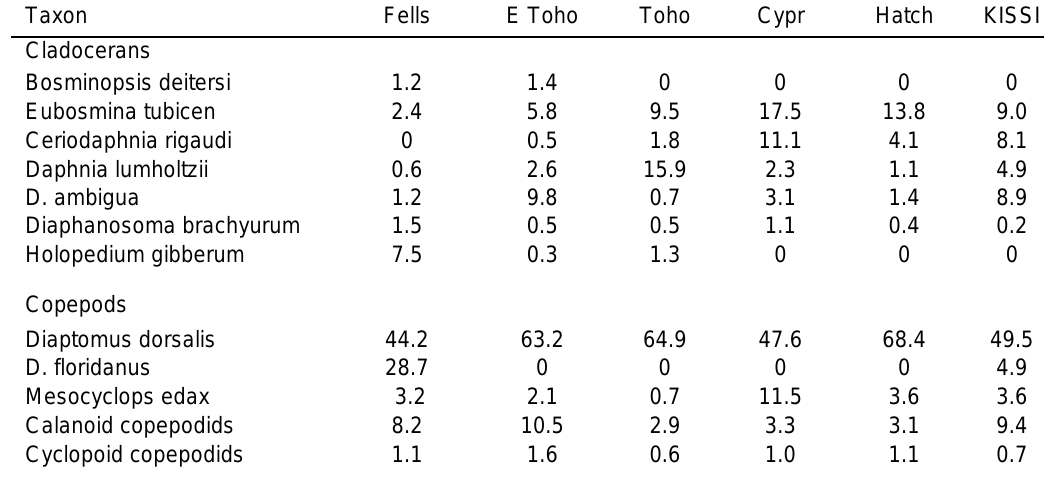
Relative Biomass (%) of Dominant Macro-Zooplankton Taxa in Six Lakes of the Kissimmee Chain, Florida,